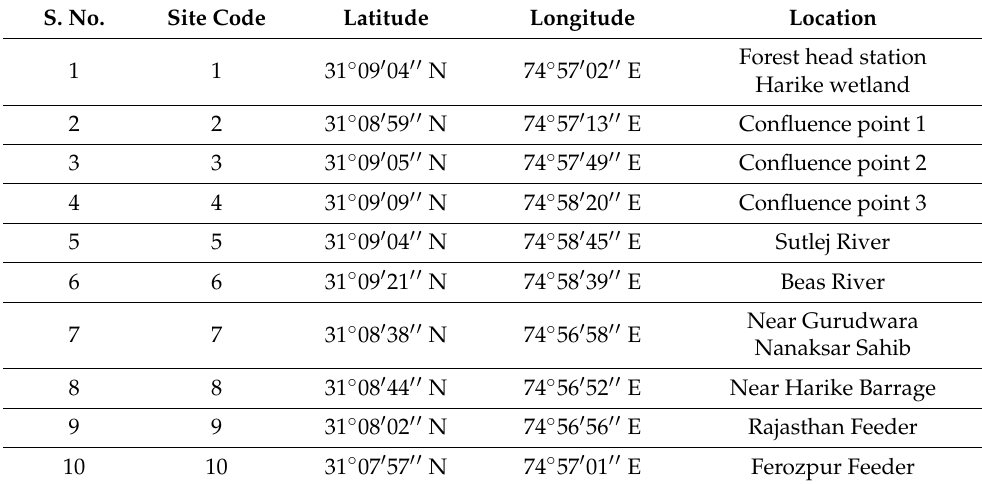
Table 1. Sampling location at Harike wetland with